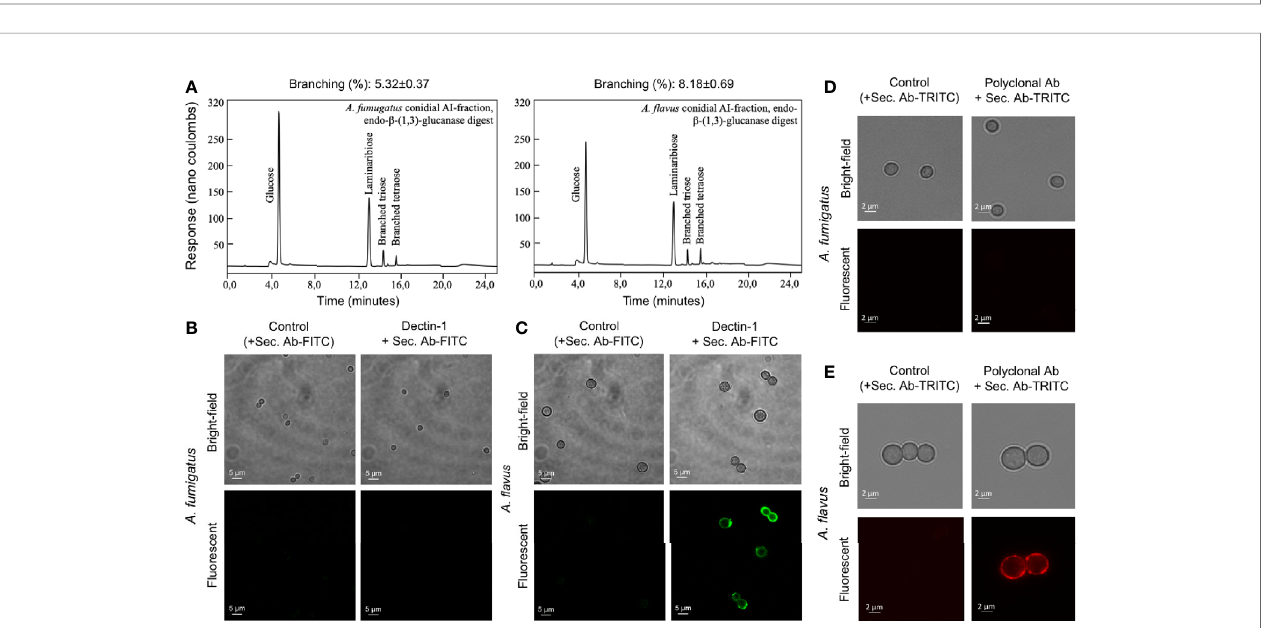
FIGURE 7 | The cell wall b -(1,3)-glucan, branching and exposure on the conidial surfaces of two Aspergillus species. (A) Conidial alkali-insoluble (AI) fractions of the two Aspergillus species were digested with endo- b -(1,3)-glucanase (LamA) and the solubilized materials were subjected to anion-exchange chromatography (DIONEX). b -(1,3)-Glucan branching percentages were calculated based on the peak areas in the chromatography pro fi les. (B) A. fumigatus and (C) A. fl avus conidia were labelled for b -(1,3)-glucan with human-Fc conjugated Dectin-1 and anti-human-Fc-speci fi c IgG-FITC; conidia treated by only secondary antibody served as the controls. (D) A. fumigatus and (E) A. fl avus conidia were labelled for a -(1,3)-glucan with mouse polyclonal antibody speci fi c for a -(1,3)-glucan and anti-mouse IgG- TRITC; conidia treated by secondary antibody served as the